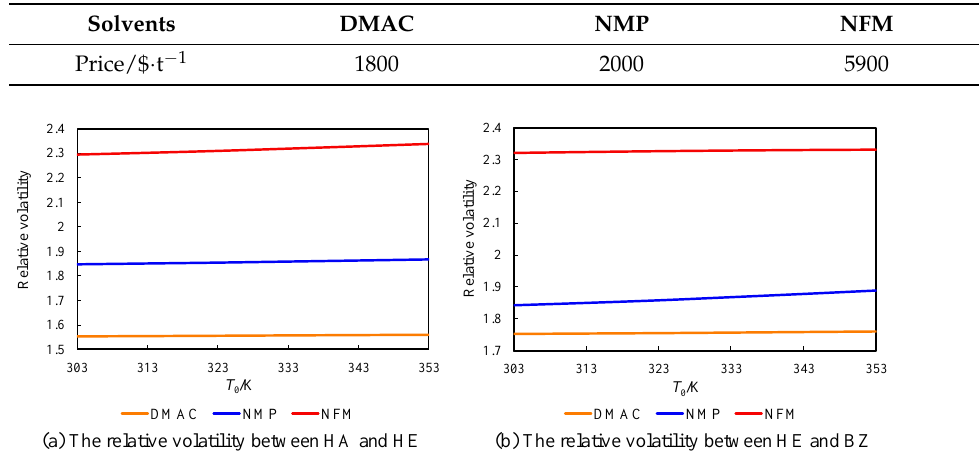
(b) The relative volatility between HE and BZ(a) The relative volatility between HA and HE Figure 7. Variation of relative volatilities along reactor’s inlet temperature ( SF = 3). For each solvent, the relative volatility of components changes along the solvent-to- feed ratio. For example, when the feed temperature is 323 K, the molar composition of the reactor effluent is 18% HA, 30% HE and 52% BZ. For three candidate solvents, the varia- tion of relative volatility along the solvent-to-feed ratio is plotted in Figure 8. It can be seen that the relative volatility increases along the solvent-to-feed ratio or flowrate of sol- vent, no matter which solvent is used. However, increasing solvent’s flowrate will in- crease duty of separation and cost of solvent, and hence will cause an increment of the system’s TAC.